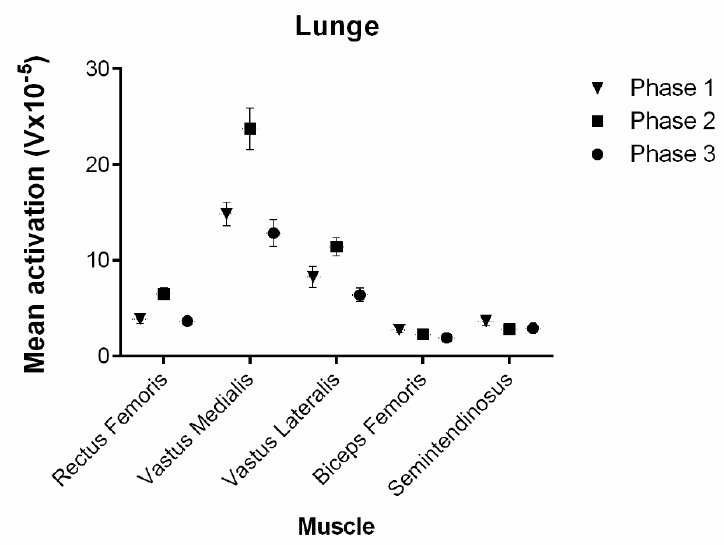
Figure 6. Mean activation (V × 10 − 5 ) of all the muscles in each phase in lunge. The first phase corresponds to the descent, the second to the isometric phase and the third to the ascent. The vertical lines around the data represent the SD.